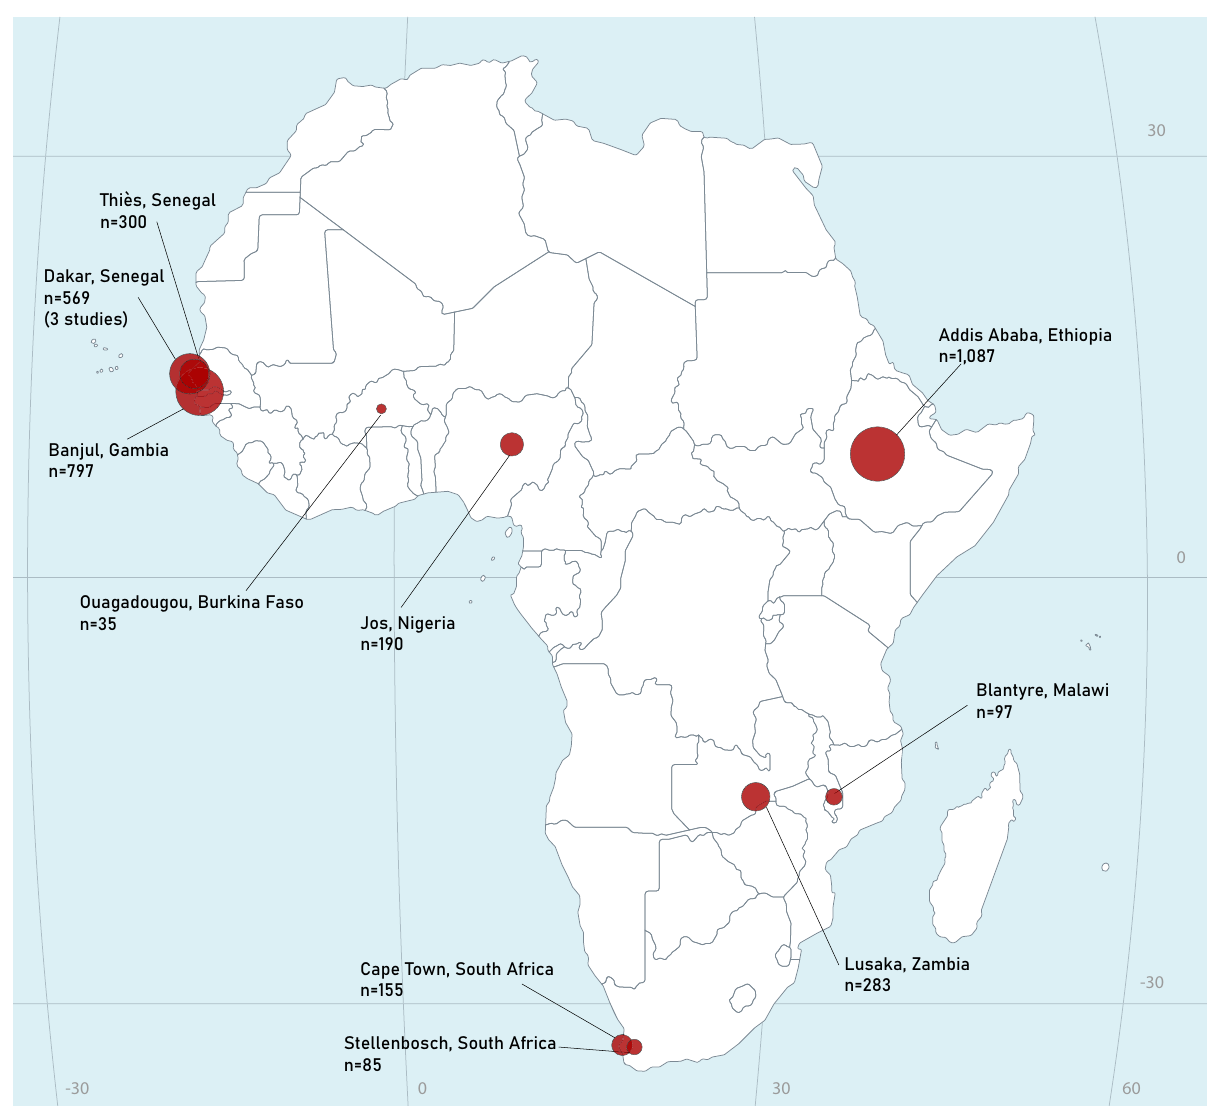
Fig. 1 | Map of included studies. n the number of hepatitis B patients included from each site in the current analysis. Area of circles is proportionate to cohort size. Attribution to iStockphoto